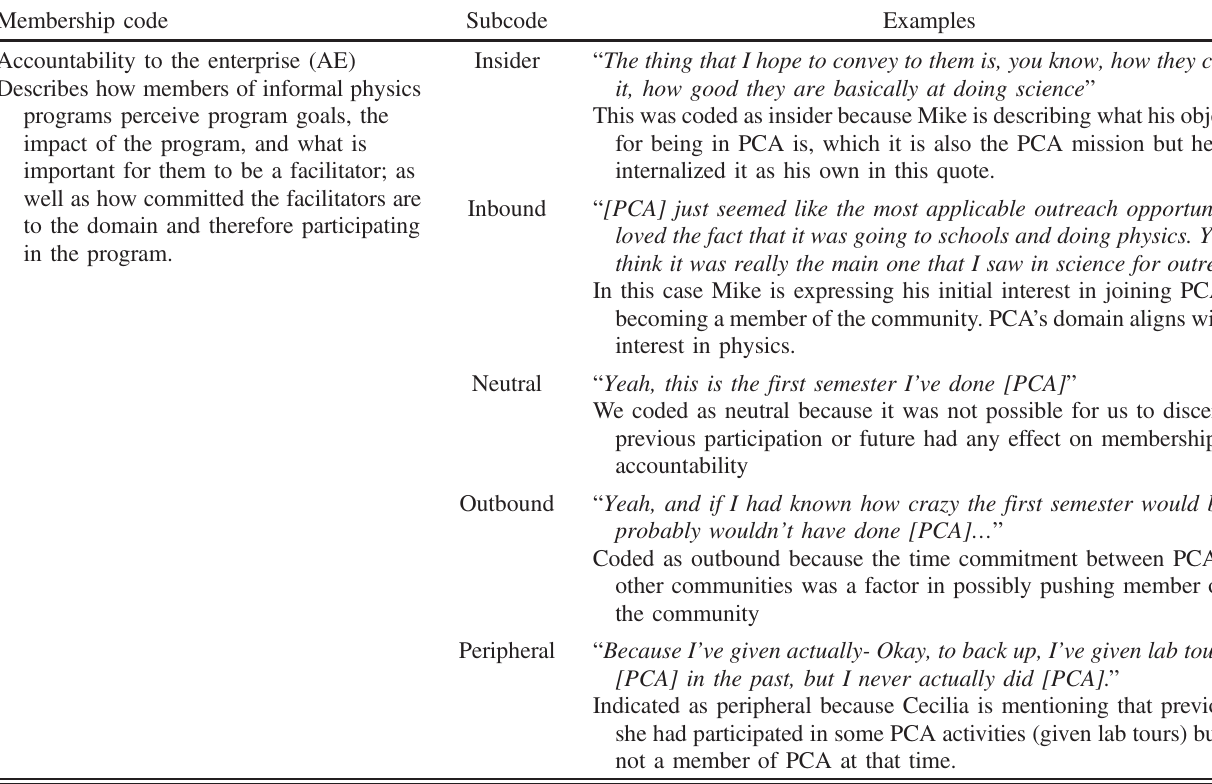
TABLE III. Examples and explanations for each subcode under the accountability to the enterprise construct.